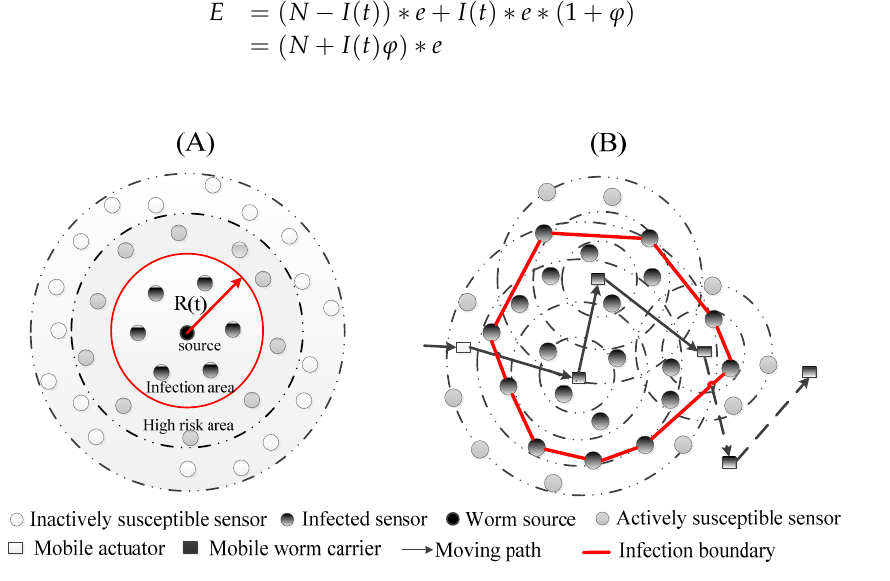
Figure 1. Static sensor worm ( A ) vs. Mobile sensor worm ( B ).